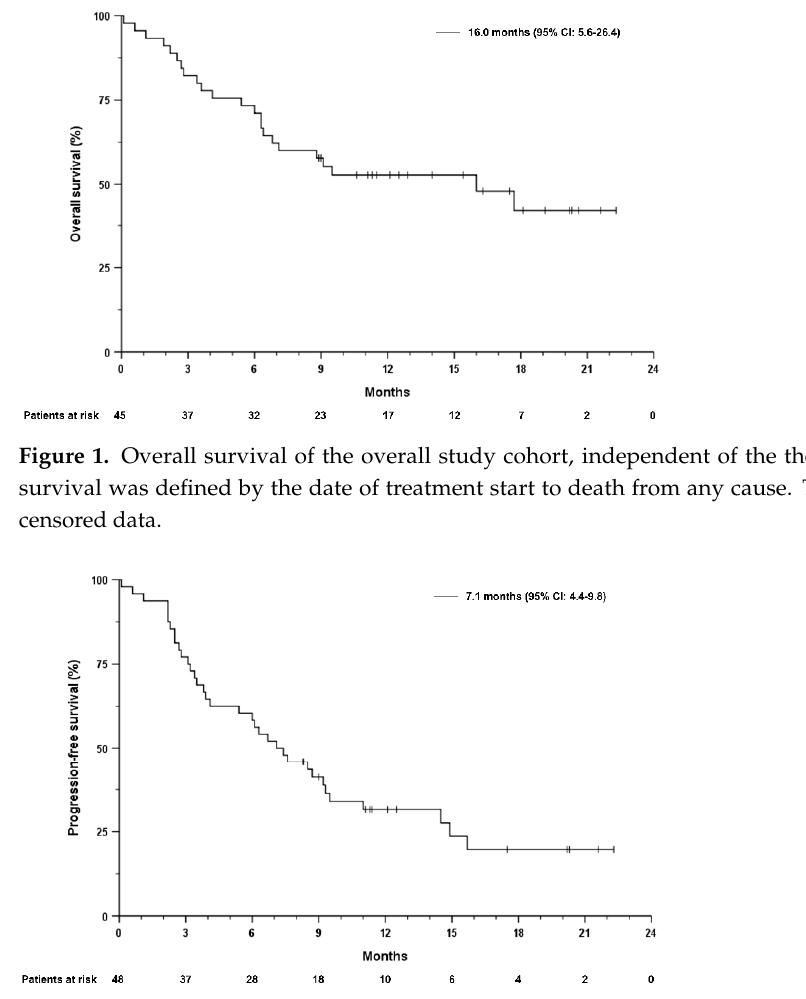
Figure 2. Progression-free survival of the overall study cohort, independent of the therapy line. Progression-free survival as the time from treatment start to radiographic progression or death from any cause. Tick marks indicate censored data.